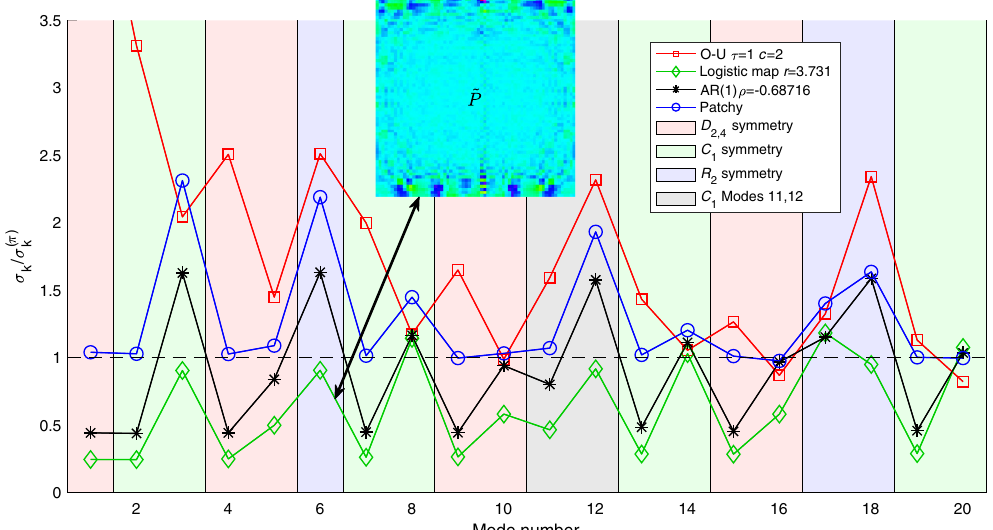
FIG. 8. Stationary stochastic processes and deterministic chaos characterized by patterns of rank sample variability. The y axis gives the standard deviation σ of the modal coefficients normalized by the π -noise values. Three models are stationary stochastic processes: (1) Ornstein-Uhlenbeck, (2) “ patchy ” δ -correlated, and (3) first-order autogressive [AR(1)]. The fourth is the chaotic logistic map (examined further in Sec. VII). For the parameters noted in the legend, the AR(1) and logistic models have essentially equal ACFs but distinct fingerprints. Both dip below the π noise because of the negative correlation at small lags, reducing the likelihood of a spurious ˜ P trend. The inset shows (the ensemble mean P without its D 4 component) for the logistic map. For all independent stationary stochastic ˜ P ˜ P ≠ 0 processes, . The patchy process illustrates that δ -correlated processes can still ¼ 0 , but for all deterministic processes, like here, have nontrivial fingerprints. The most telling feature of the O-U process is its greatly increased probability of spurious linear trends relative to π noise as indicated by its off-scale value for mode 1 of